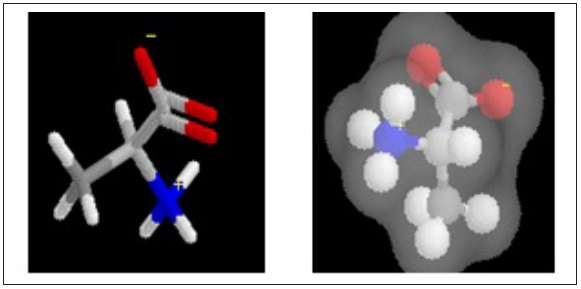
Two different visual representations of the same amino acid used in Probe